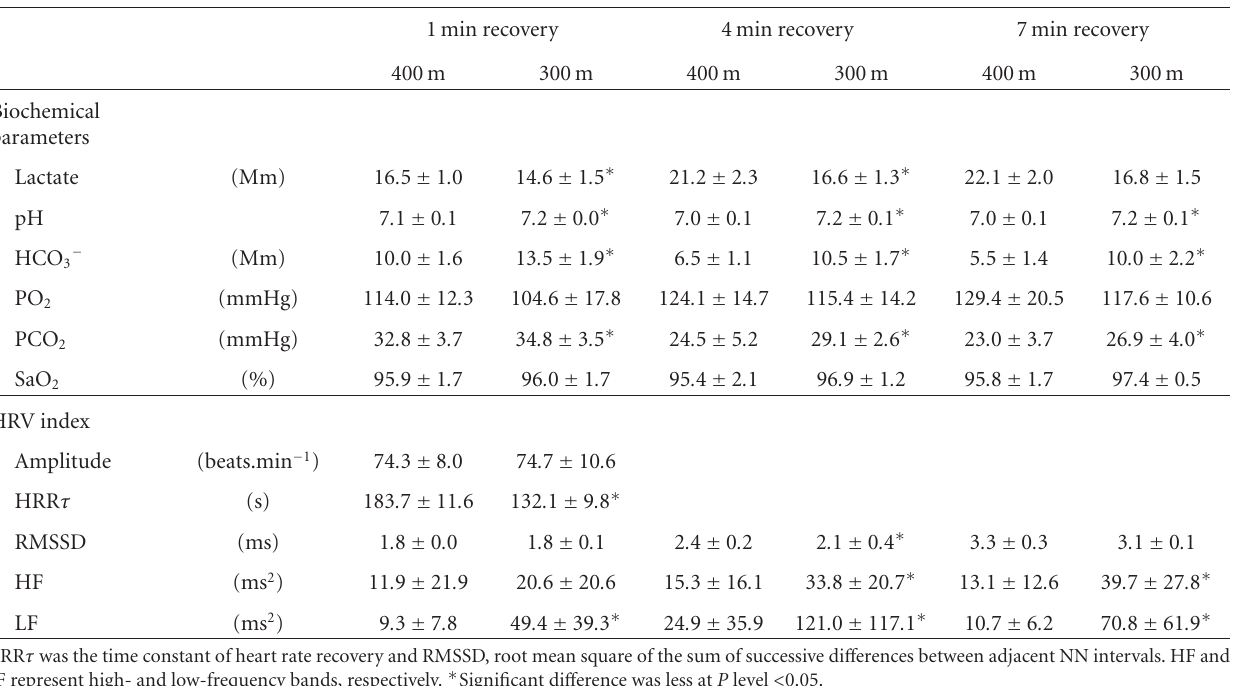
Table 1: Biochemical and heart rate variability parameters measured during the postexercise recovery.